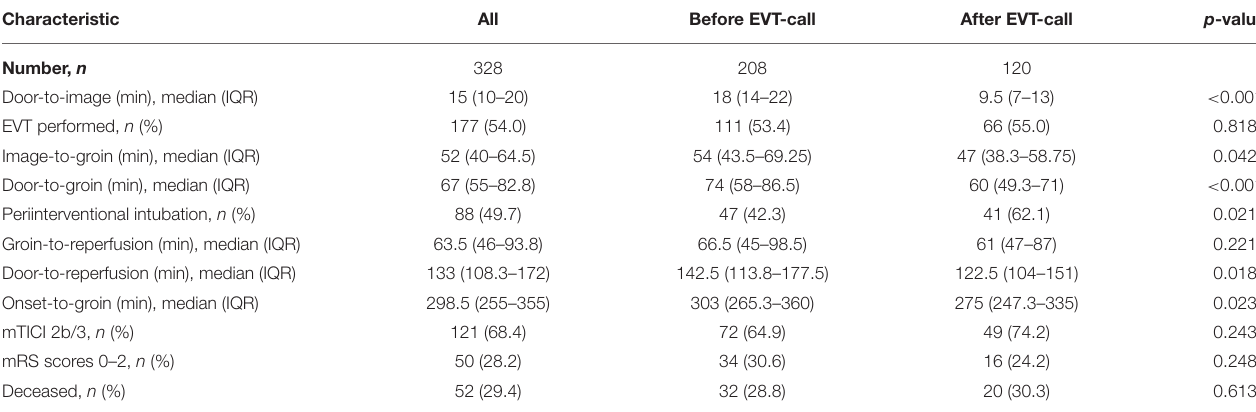
TABLE 2 | Time metrics and outcome parameters according to implementation of the EVT-call; EVT indicates endovascular therapy; IQR, interquartile range; mRS, modified Rankin Scale, mTICI, modified Treatment in Cerebral Infarction. Characteristic